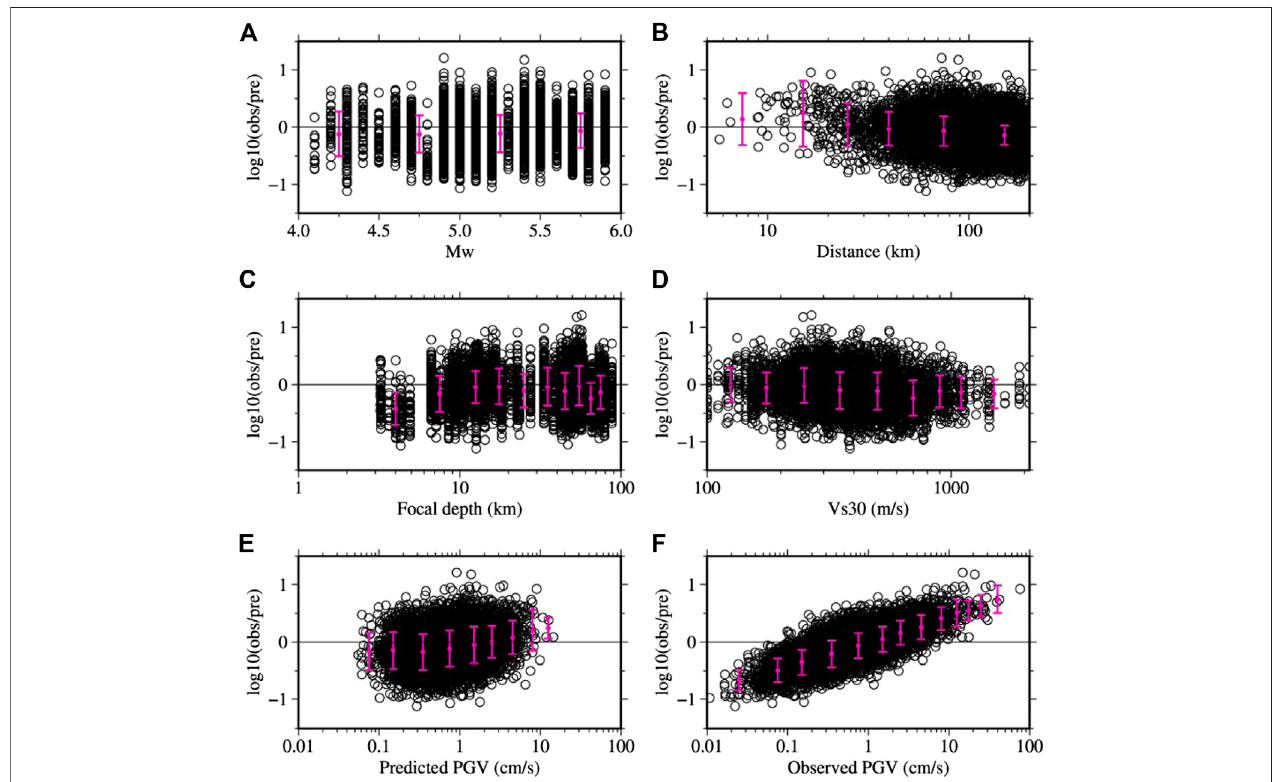
FIGURE6| PlotsofresidualsforPGVdataplottedin Figure3B forhypocentraldistancessmallerthan200 km.The (A – F) showthedistributionofresidualsagainst the Mw, hypocentral distance, focal depth, Vs30, predicted PGA, and observed PGA, respectively. The vertical bars denote the mean values with plus-minus one standard deviation of the binned